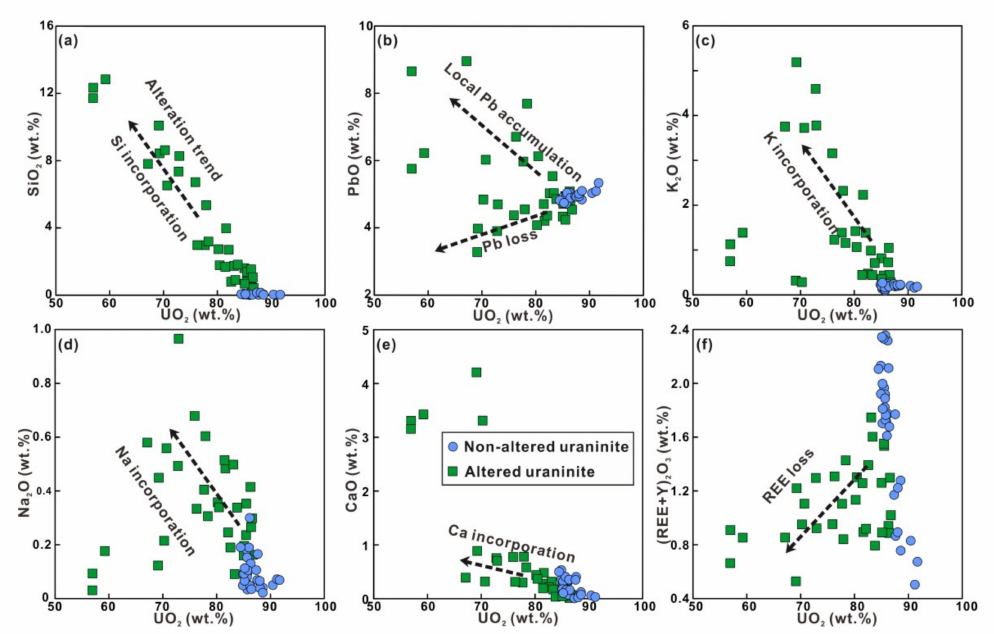
Figure 5. Compositional variations for U, Pb, Si, K, Na, Ca and REE (including Y) between non- altered and altered uraninite from the Guangshigou deposit. ( a ) UO 2 vs. SiO 2 . ( b ) UO 2 vs. PbO. ( c ) UO 2 vs. K 2 O. ( d ) UO 2 vs. Na 2 O. ( e ) UO 2 vs. CaO. ( f ) UO 2 vs. REE 2 O 3 (including Y 2 O 3